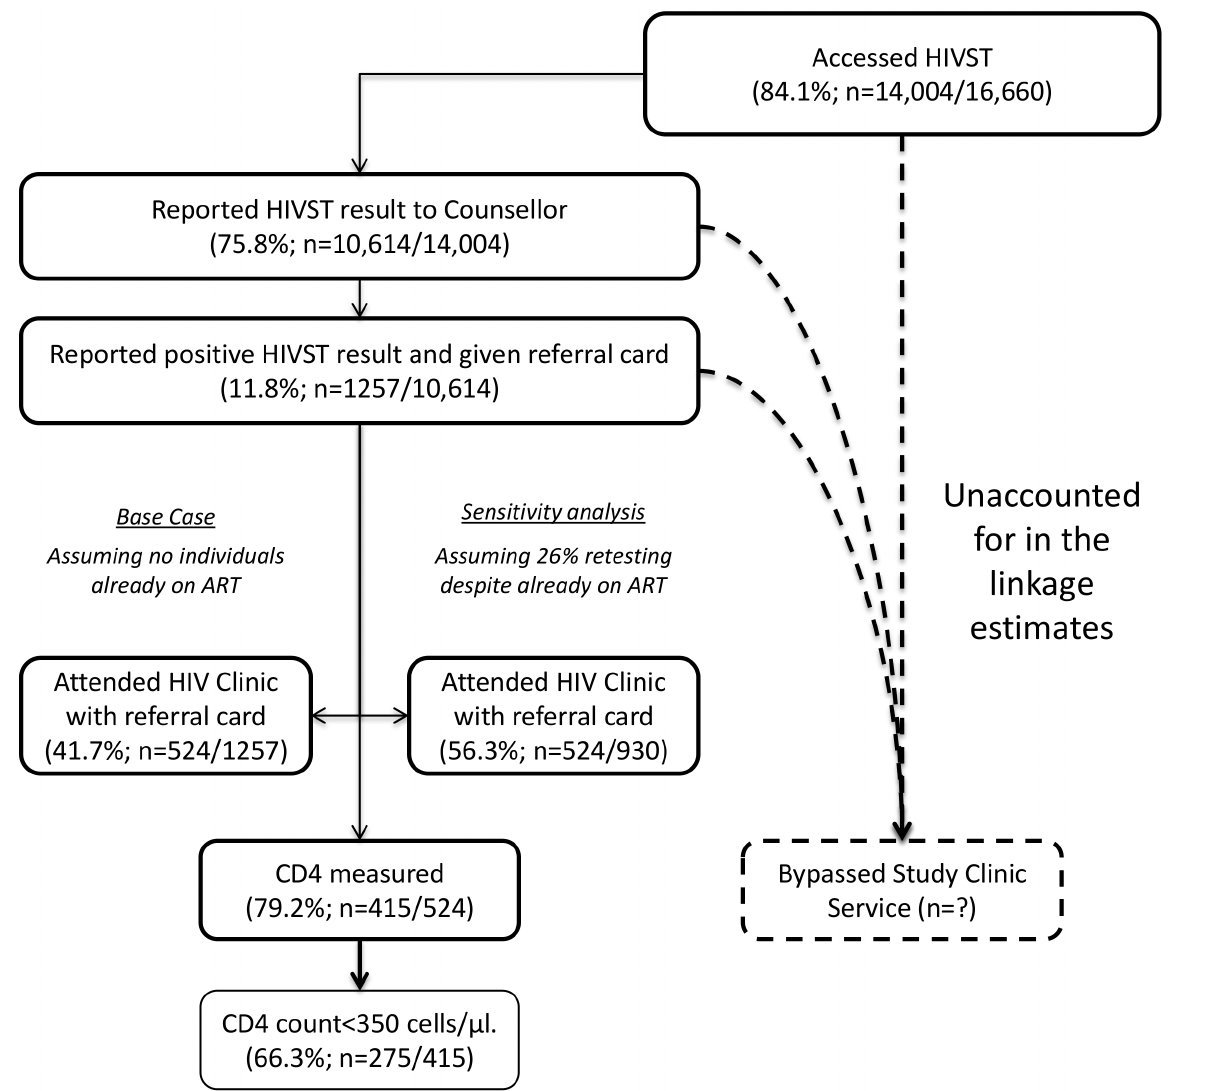
Fig 5. Linkage into HIV care after HIV self-testing (months 1 –